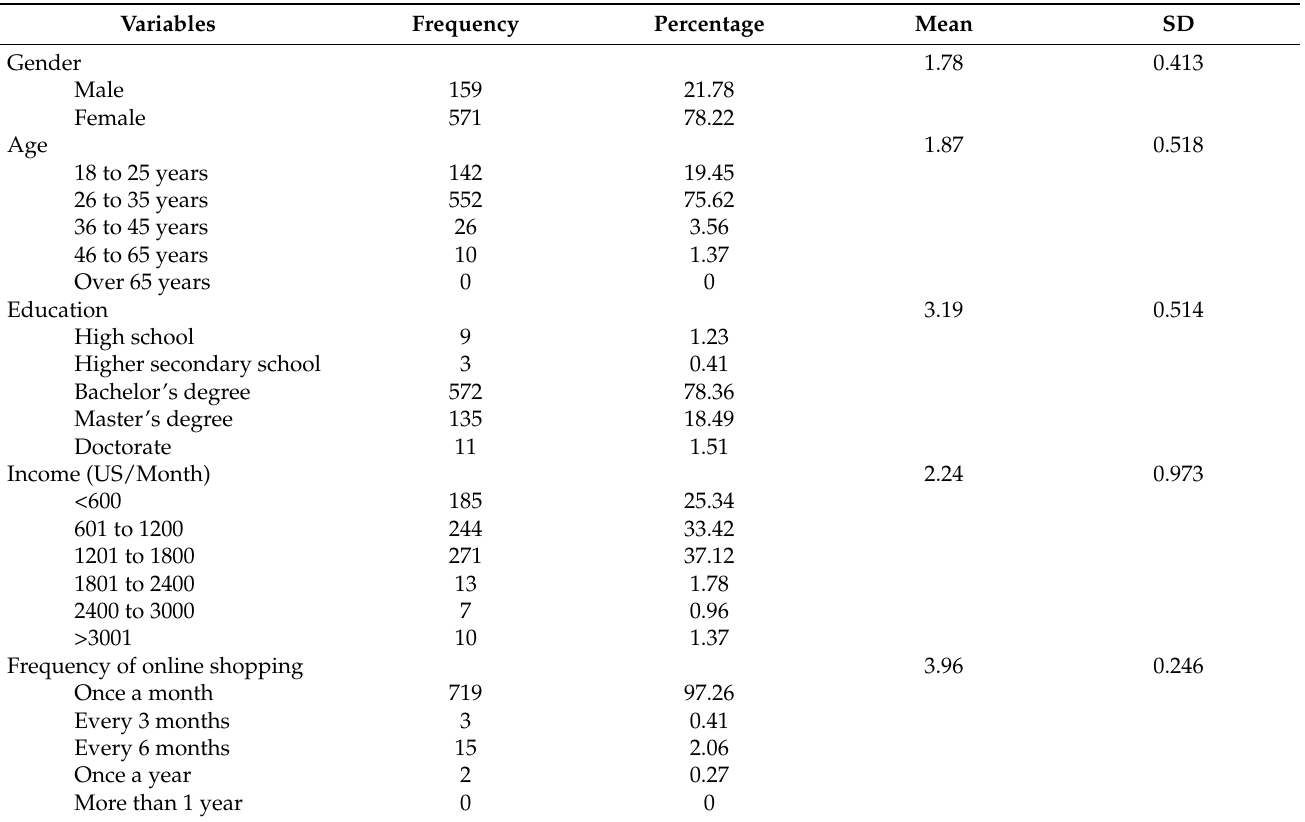
Table 1. Demographic